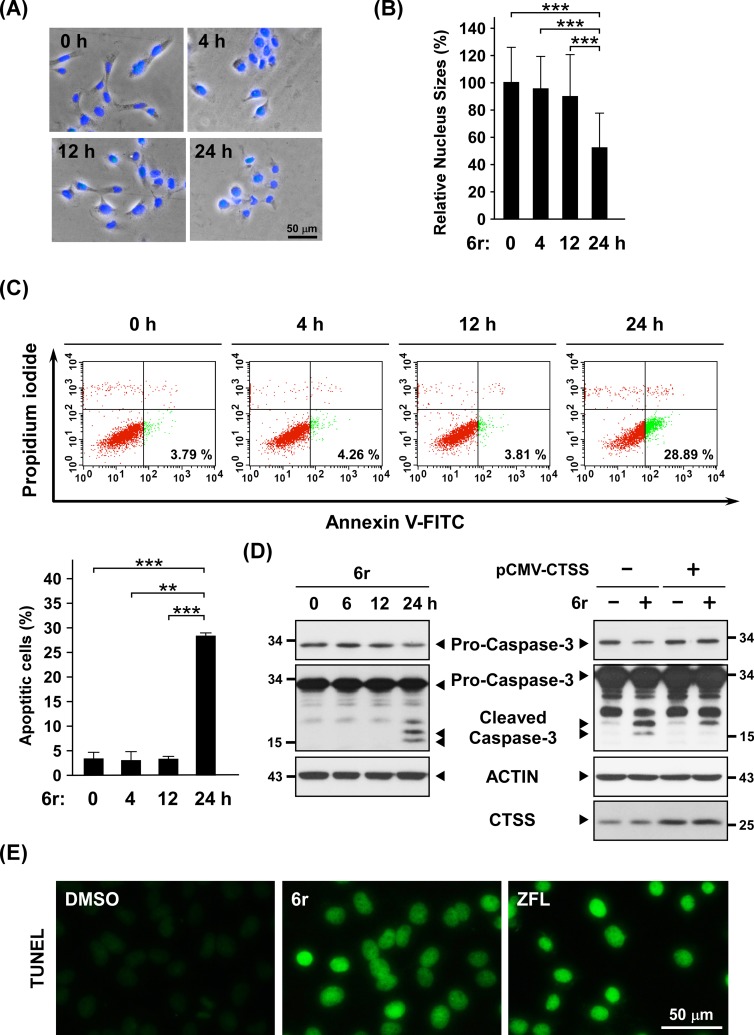
Inhibition of CTSS activities induces apoptotic hallmarks.(A) After OEC-M1 cells were incubated with DMSO or 20 μM of the CTSS inhibitor 6r for the indicated time points, the cells were fixed with 4% paraformaldehyde, and stained with DAPI. The cell morphology and nucleus were monitored under a phase-contrast and a fluorescent microscope, respectively. Merged images are shown. (B) Cells were treated with 20 μM of 6r at different times. Nuclei were stained with DAPI, and images were taken using the fluorescent microscope. Relative nuclear sizes were analyzed using the Image Pro Plus software. Nuclear area was defined as the area within the outlined nuclear perimeter. Differences were found to be statistically significant at ***P < 0.001. (C) Time-course analysis of apoptosis during 6r treatment. Cells were exposed to 20 μM of 6r at the indicated time points, harvested, and stained with Annexin V and PI, as described in the materials and methods section. The numbers of apoptotic cells were quantified using flow cytometry. Data shown in the below panel are representative of 3 independent experiments. Differences were found to be statistically significant at **P < 0.01 and ***P < 0.001. (D) Left panel: Cells were treated with 20 μM of 6r for various durations, and cleaved caspase-3 fragments were analyzed through western blotting. The upper panel indicates short-term exposure of the blot. ACTIN was shown as an internal control for semiquantitative loading in each lane. Right panel: After OEC-M1 cells were transfected with pCMV vector or pCMV-CTSS for 24 h, cells were subsequently treated with 20 μM of 6r for additional 24 h. Compared to vector control cells, cells with increased CTSS expression showed reduced caspase-3 activation upon 6r treatment. (E) Representative images of a TUNEL assay in cells treated with 20 μM of 6r or ZFL for 24 h. Apoptotic cells display TUNEL-positive nuclei stained green.